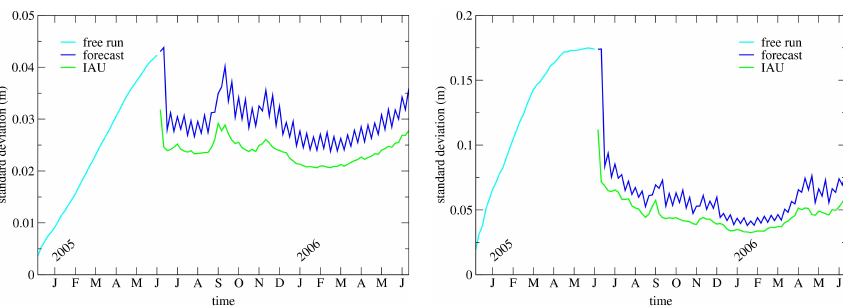
Figure 7. SSH time series of standard deviations for free-run, forecast and IAU ensembles over the Gulf Stream verification area (left panel) and the Z focus area (right panel).